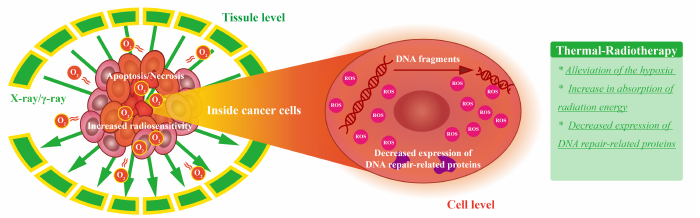
Figure 3. The mechanism of synergetic thermal therapy and radiation therapy. After heating to 45 ◦ C several minutes before/during radiation, the radio-resistant of cancer cells are sensitized and the hypoxia degree of tumor is alleviated by the recruitment of oxygen. Thus, (1) increased damage to DNA by direct radiation or generated ROS is achieved, and (2) decreased expression of DNA repair-related proteins is realized. These two factors lead to the enhanced killing of cancer